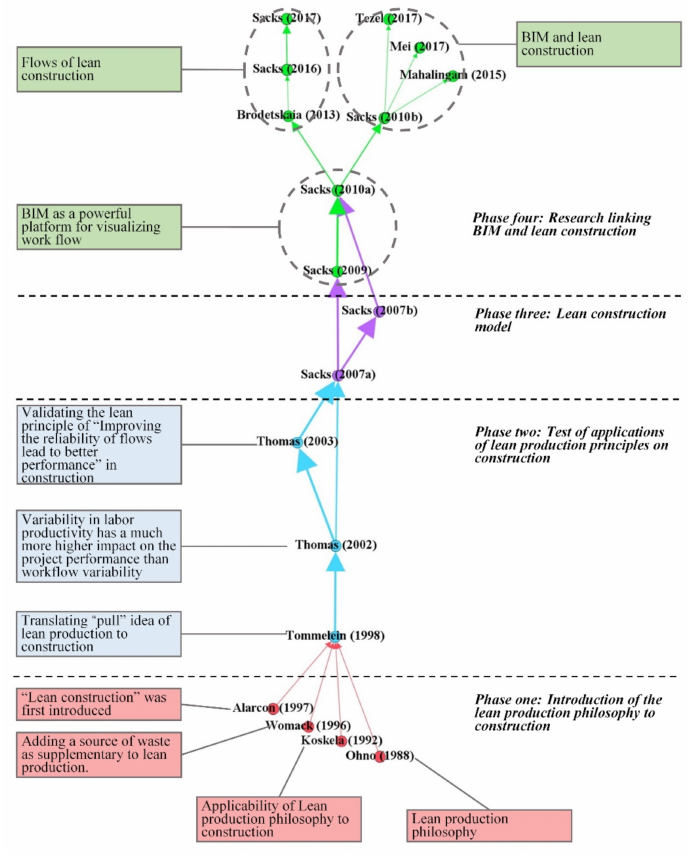
Figure 4. The main path of Lean Construction in Building